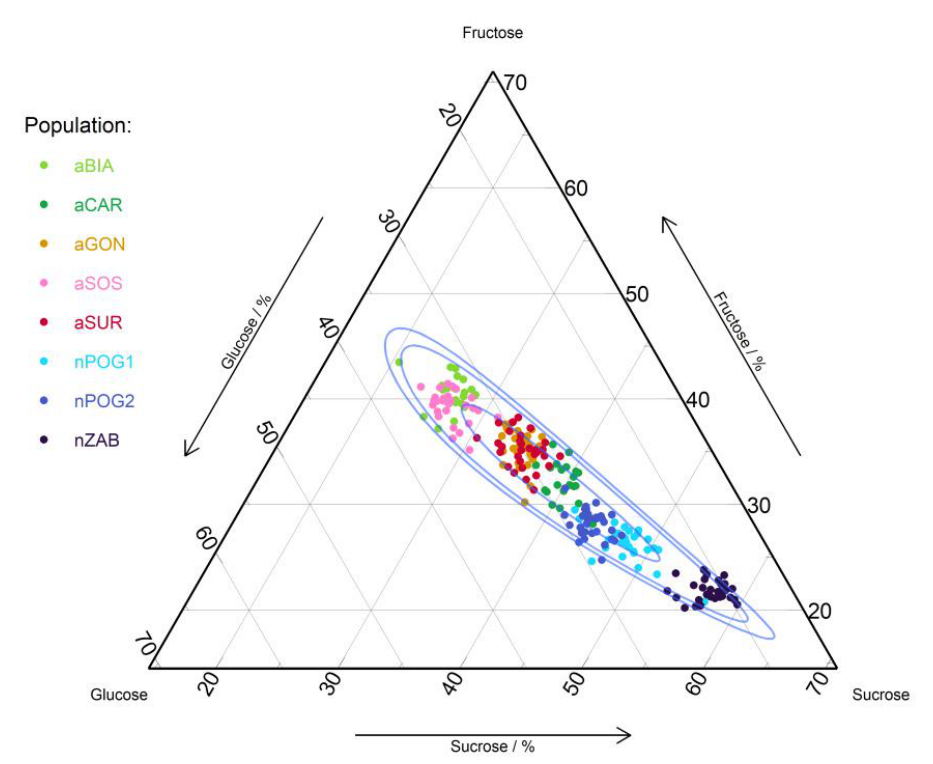
Figure 1. Ternary plot of sugars for anthropogenic (aBIA, aCAR, aGON, aSOS, and aSUR) and natural (nPOG1, nPOG2, and nZAB) populations of Epipactis helleborine . The blue lines show the 50%, 90%, and 95% confidence intervals using the Mahalanobis distance and the log-ratio transformation. Table 2. Sugar concentration ( µ M) in Epipactis helleborine nectar. Data represent the mean (x) ± standard error (SE), lower quartile (Q 1 ), median (Q 2 ), upper quartile (Q 3 ), interquartile range (IQR), and biological replicate (n). Different letters indicate statistically significant differences according to the pairwise Wilcoxon rank sum test with the Benjamini–Hochberg adjustment ( p <